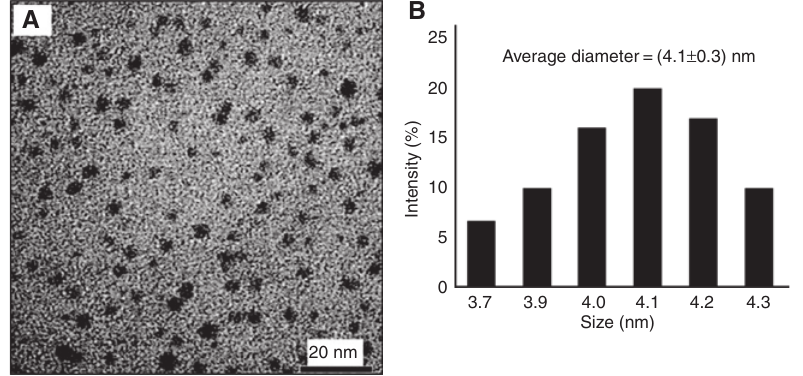
Figure 1: TEM image (A) and particle size distribution (B) of Ag@CS.